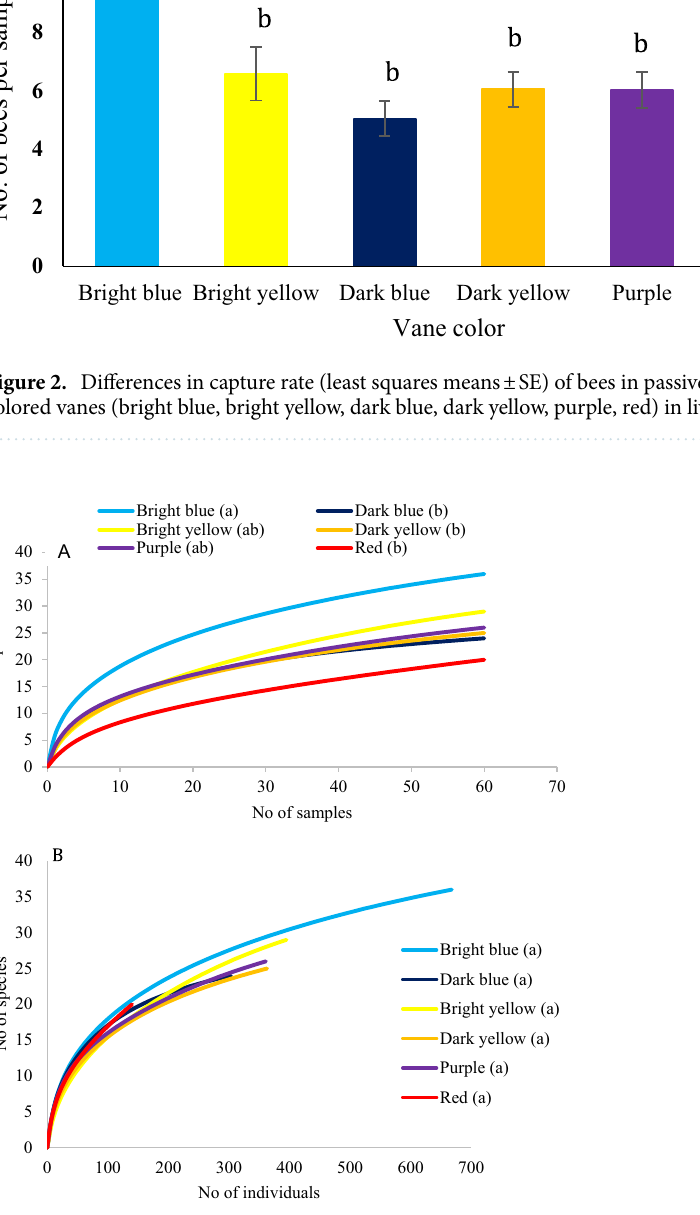
Figure 3. Rarefaction curves showing accumulation of the number of species in relation to the number of samples ( A ) and number of individuals ( B ). Different small letters after color type inside parenthesis indicates significant differences based on non-overlapping 95% confidence